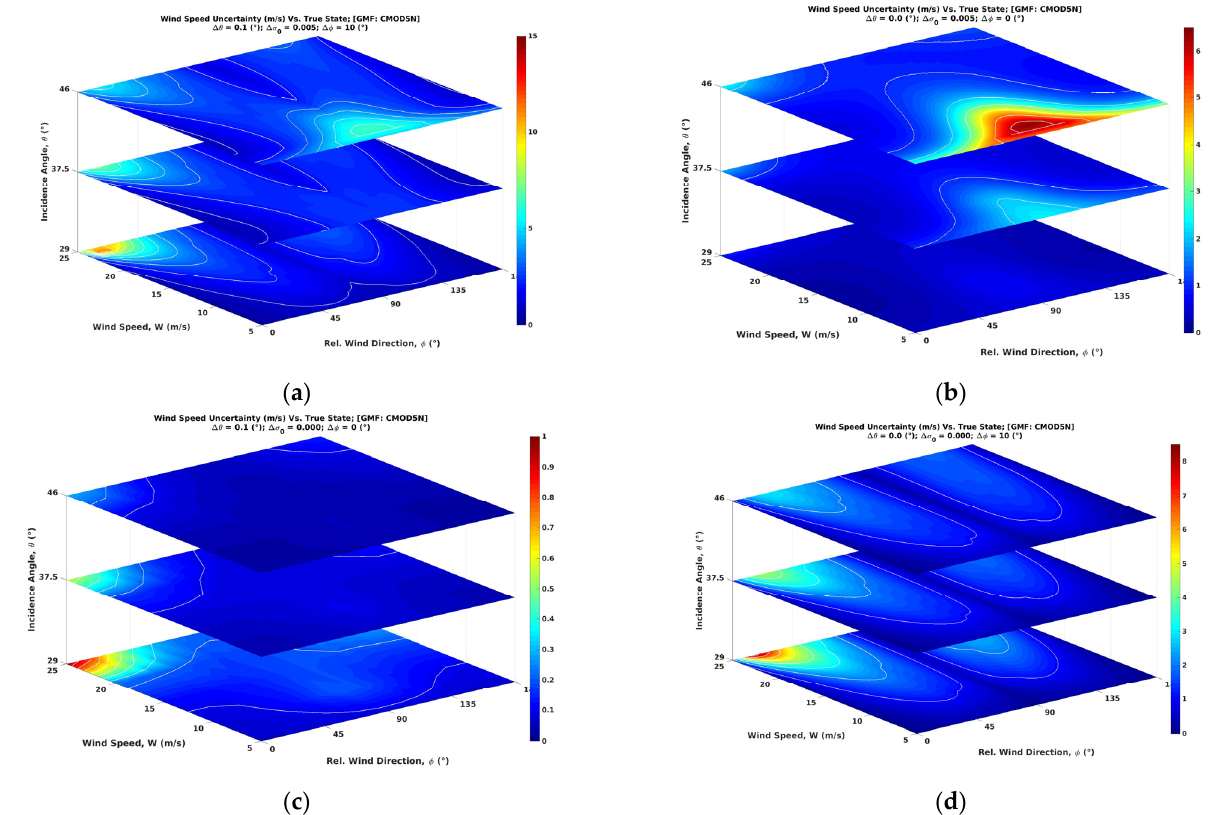
Figure 3. The total C-band MODel 5.N (CMOD5.N)-derived SAR SSW speed uncertainty Δ W max (m/s), due to both the fixed triplet of uncertainties ( Δσ 0 , Δθ , Δφ ) = (0.005,0.1°,10°) and the varying true state (W, θ , φ ) ( a ). The contribution to this uncertainty only due to a single uncertainty among the ones regarding NRCS ( Δσ 0 = 0.005) ( b ), incidence angle ( Δθ = 0.1°) ( c ), and MS LG-Mod SSW (relative) direction ( Δφ = 10°) ( d ), with the same true state (W, θ , φ ). The wind speed uncertainty is computed for the wind direction φ from 0° (upwind) to 180° (downwind) ( x axis), the wind speed W between 5 and 25 m/s ( y axis), and the incidence angle θ of 29°, 37.5°, and 46° ( z axis).